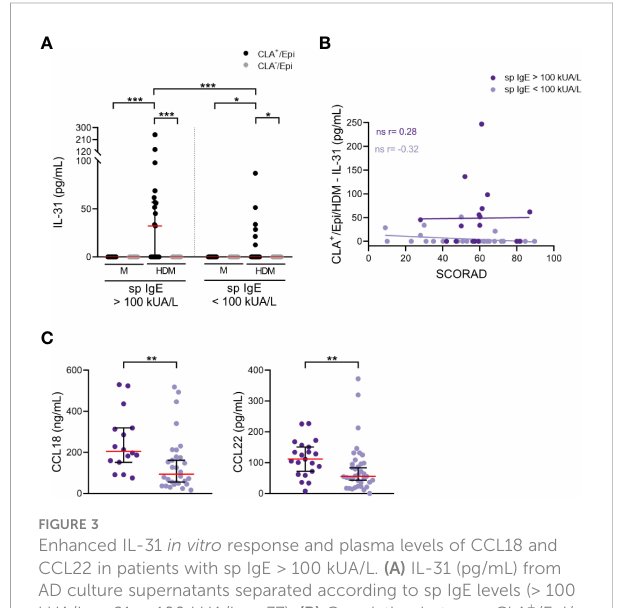
FIGURE 3 Enhanced IL-31 in vitro response and plasma levels of CCL18 and CCL22 in patients with sp IgE > 100 kUA/L. (A) IL-31 (pg/mL) from AD culture supernatants separated according to sp IgE levels (> 100 kUA/L n=21, < 100 kUA/L n=37). (B) Correlation between CLA + /Epi/ HDM IL-31 and SCORAD in high (n=17) and low (n=29) sp IgE groups. (C) Plasma levels of CCL18 (ng/mL) and CCL22 (pg/mL) were compared between high (n=16-21) and low (n=30-37) sp IgE groups. CLA, cutaneous lymphocyte-associated antigen T cells; Epi, epidermal cells suspension; HDM, house dust mite; M, untreated; sp IgE, speci fi c IgE to house dust mite; SCORAD, scoring atopic dermatitis. ns: p >.05; *p <.05; **p <.01; ***p <.001.